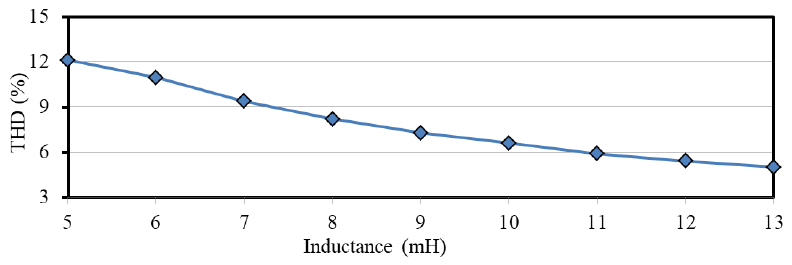
Figure 16. THD vs. Inductance